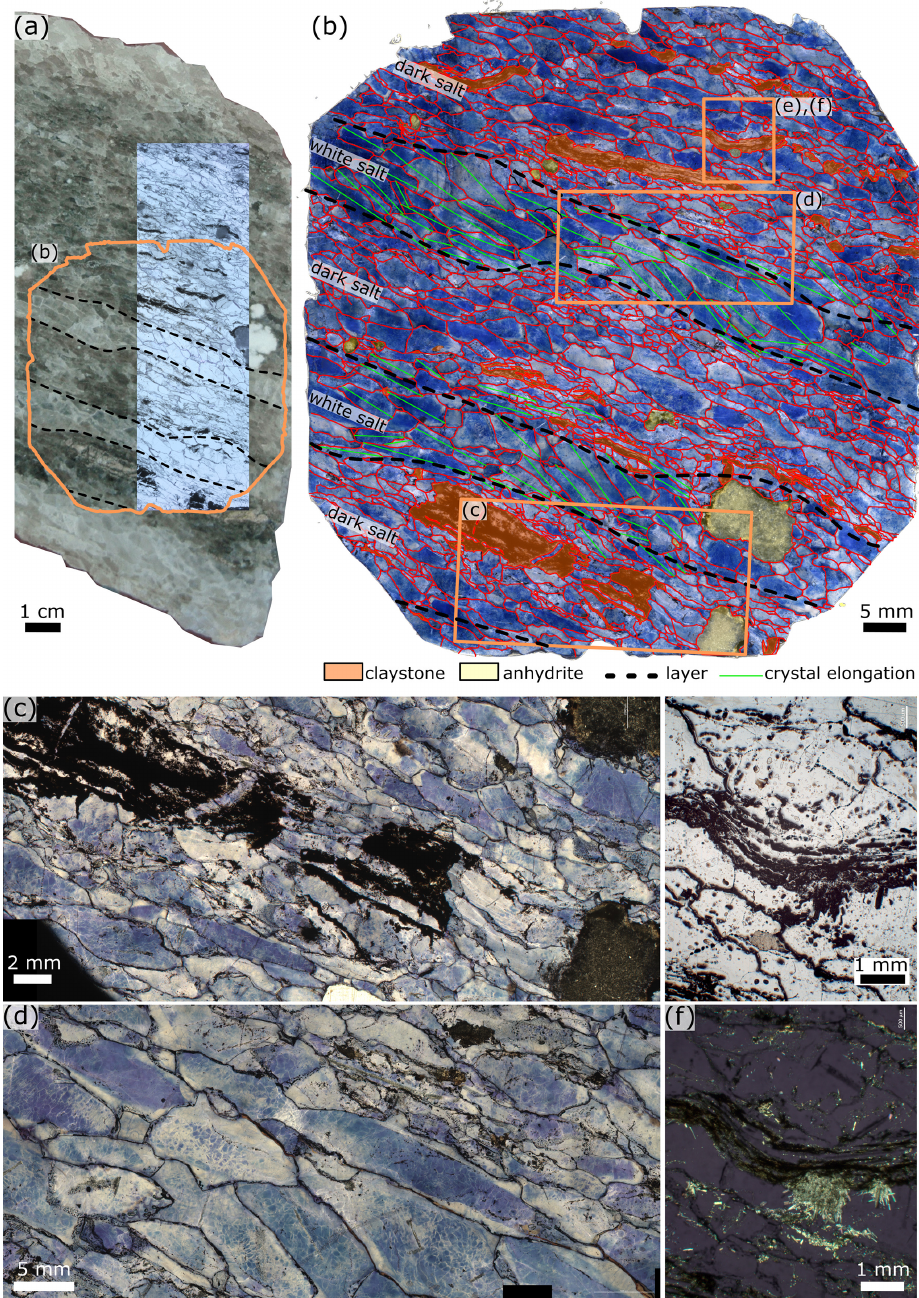
Figure 11. (a) Hand specimen RO-OM-02 with a photomontaged transmitted light image of the thin section, showing bands of white and dark salt with elongated fragments parallel to the foliation. (b) Transmitted light image of a gamma-irradiated thin section of sample RO-OM-02 with blue decoration of halite microstructures and traced halite grain boundaries. Elongated claystone fragments, anhydrite, and salt layer boundaries are indicated. (c) Transmitted light micrograph showing a boudinaged claystone aggregate with thin layers of halite and fibrous halite in the boudin neck; the location is indicated in (b) . (d) Transmitted light micrograph of elongated halite grains showing subgrain-free and subgrain-rich halite cores with white overgrowth rims; the location is indicated in (b) . (e) Reflected light micrograph of grey salt and bent claystone particle as well as smaller inclusions between halite crystals; the location is indicated in (b) . (f) Cross-polarised transmitted light micrograph showing anhydrite accumulation next to a claystone particle and smaller high-interference minerals at halite grain boundaries; the location identical to (e) is indicated in (b)